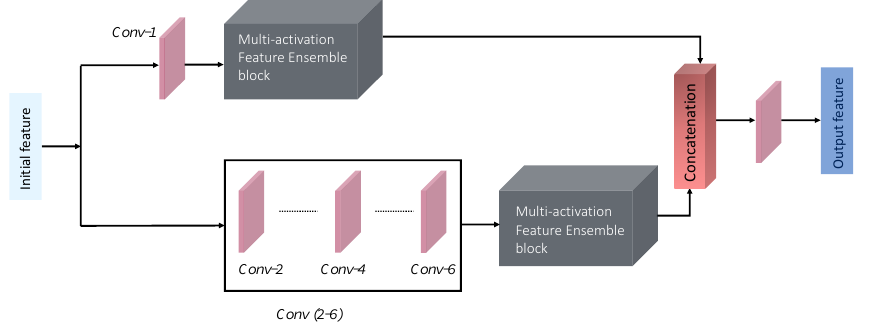
Figure 5. Multiactivated cascaded aggregation module.